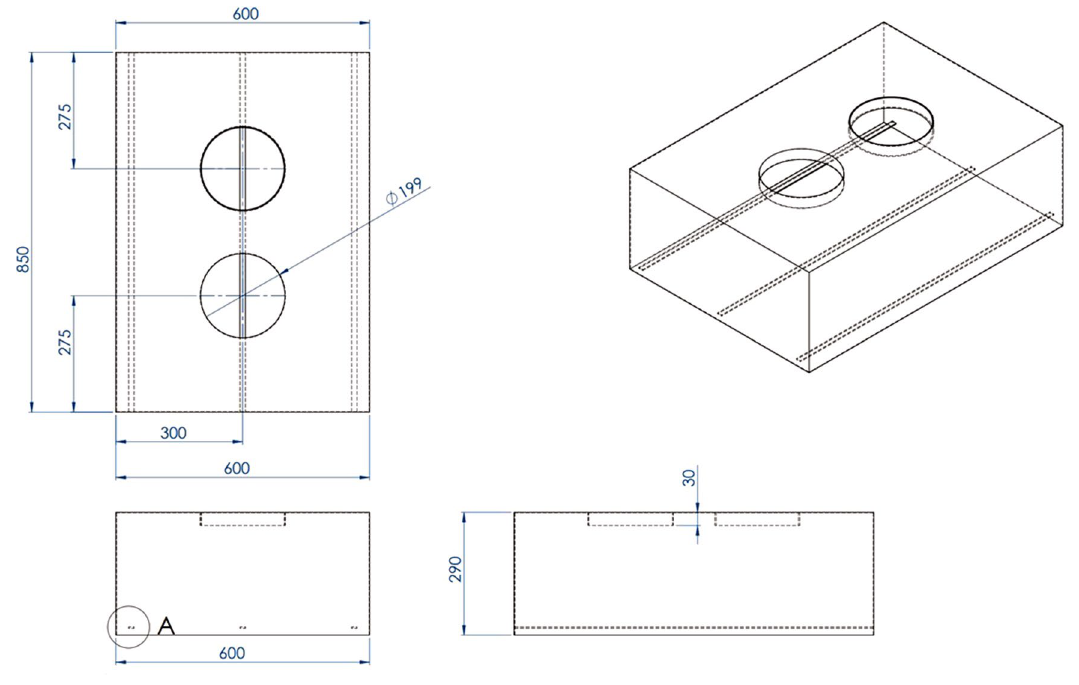
Fig. 4 Dimensions of the stainless cap (millimeter)